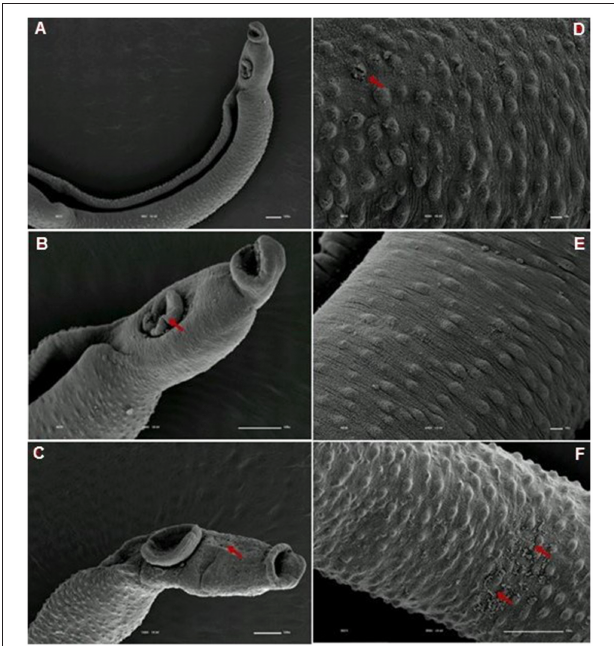
FIGURE 10 | Scanning electron microscopy of S. mansoni PZQ-resistant strain adult males after exposure to 0.3 µ M of PZQ for 3h. (A–C) Resistant strain adult males upon exposure to PZQ, presenting changes in oral and ventral suckers; (D–F) losses of tubercles and spines. Red arrows indicate alterations. Image marginations: (A) 90x 10 kV ________100u; (B) 250x 10 kV ________100u; (C) 160x 10 kV ________100u; (D) 550x 10 kV ________10u; (E) 600x 10 kV ________10u; (F) 350x 10 kV ________100u.